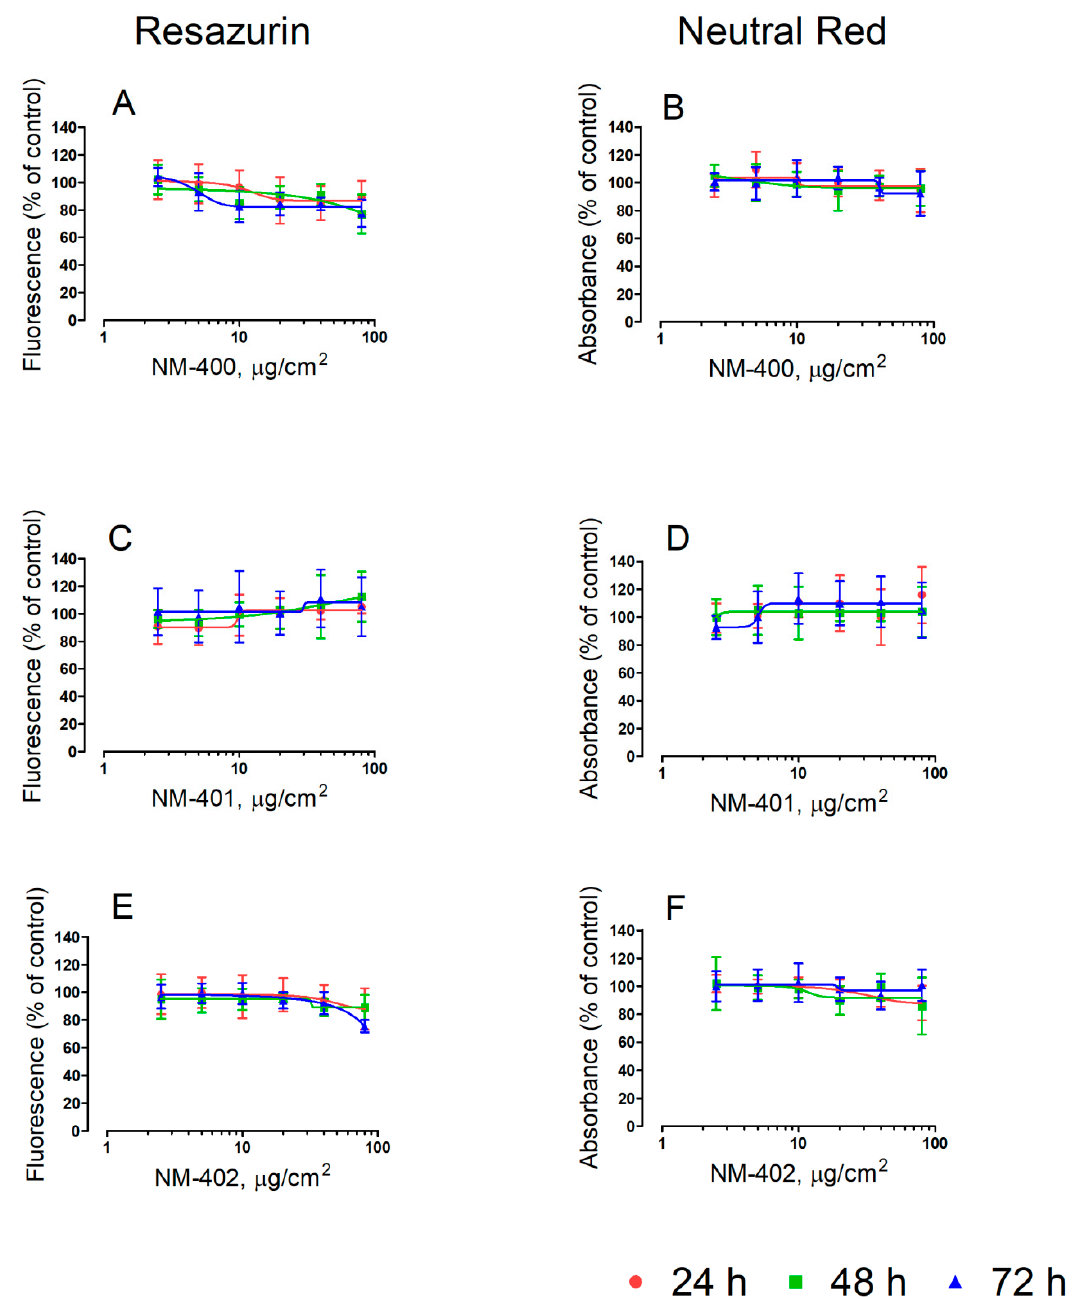
Figure 7. Calu-3 cells were grown for 24 h in complete growth medium and then exposed for 24 h, 48 h, and 72 h to the indicated doses of MWCNT. At the end of the incubation, cell viability was assessed with resazurin ( A , C , E ) or neutral red uptake assays ( B , D , F ). Data are the means ± SD of five independent determinations.